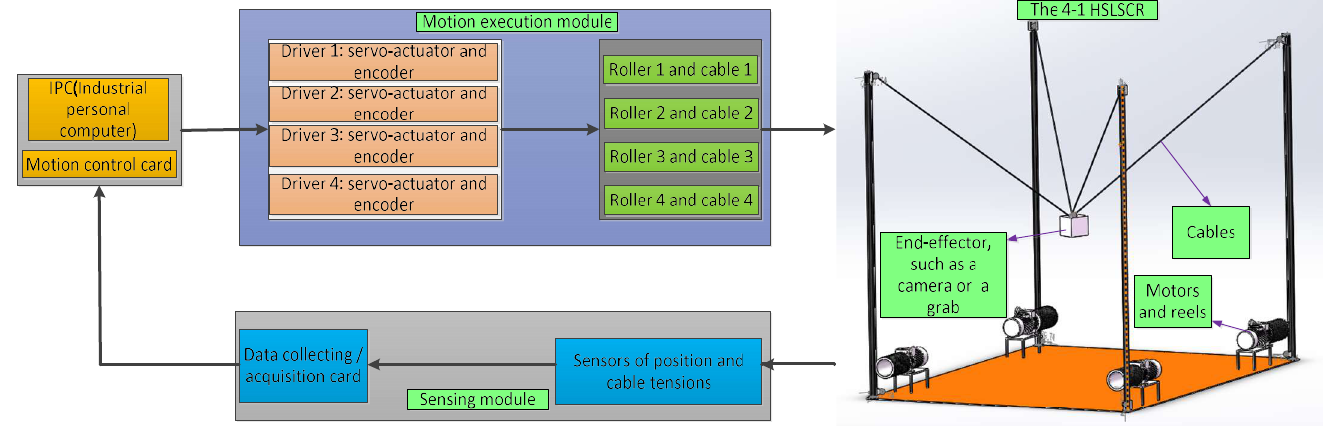
Figure 1. The composition diagram of the investigated 4-1HSLSCR.